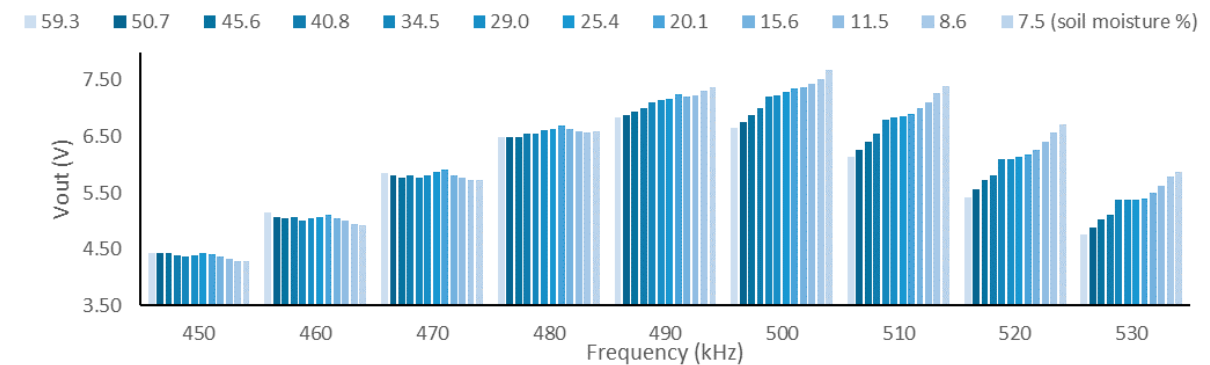
Figure 32. The Vout in the different frequencies tested in the prototype NP4.